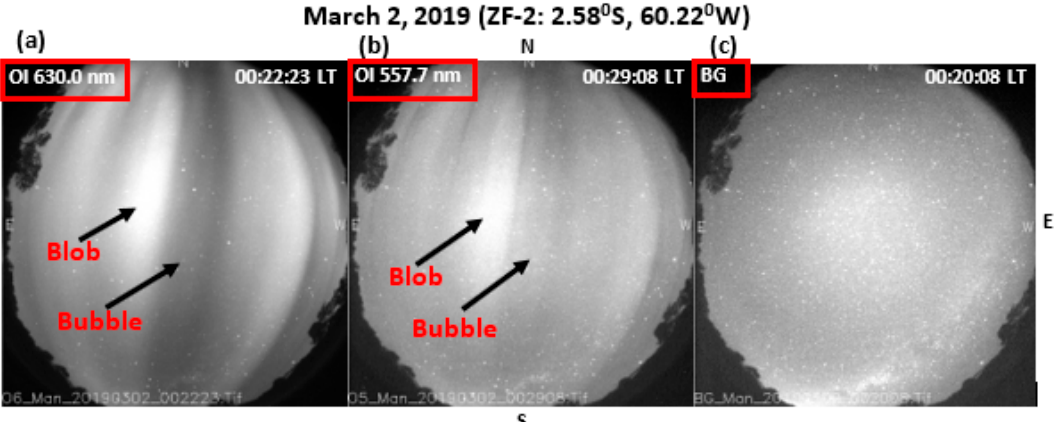
Figure 3. Raw all-sky images. The bubble and blob were spectral, being only visible at the 630 nm ( panel a ) and 557.7 nm ( panel b ) emissions and not in the control/background (BG) 598 nm wave- length, as shown in ( panel c ).